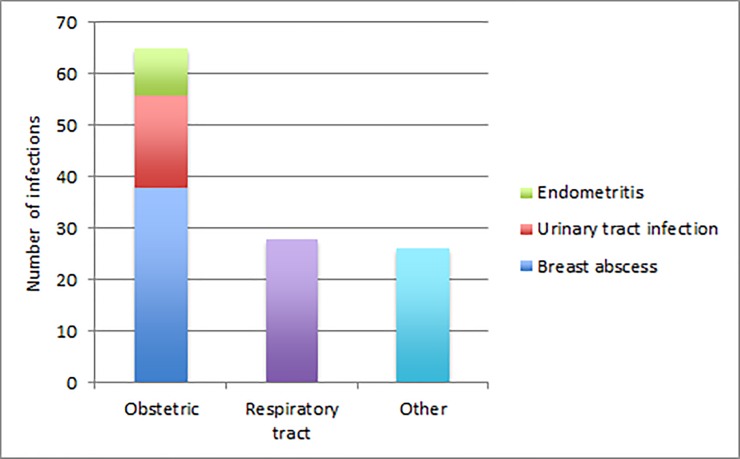
The distribution of infections, in absolute numbers, from delivery up to eight weeks postpartum.